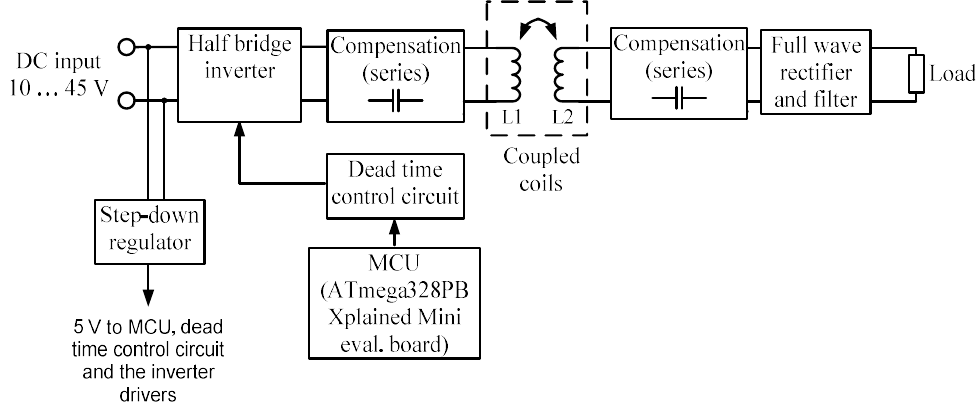
Figure 5. A block diagram of the experimental prototype.